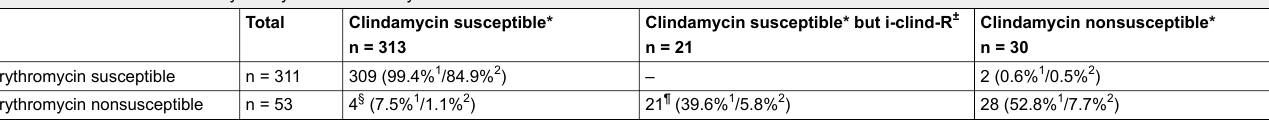
Table 1: Association between erythromycin and clindamycin